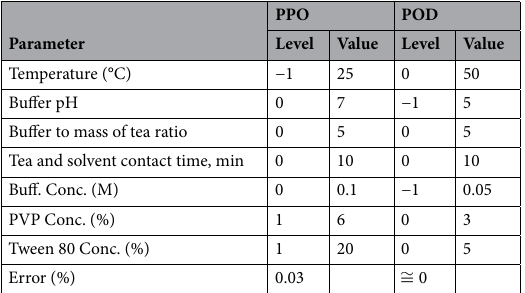
Table 3. Optimized level and value for operation parameters by Design Expert 11.